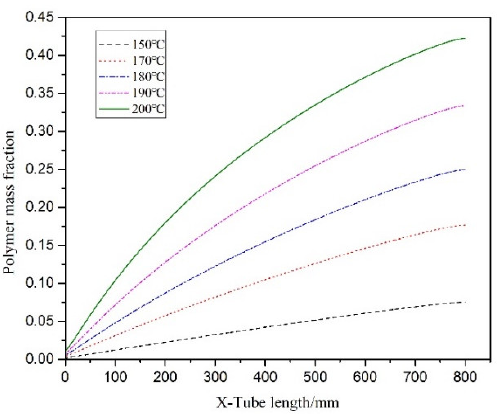
Figure 12. Temperature curves of the central axis at different jacket temperatures. Processes 2020 , 8 , x FOR PEER REVIEW